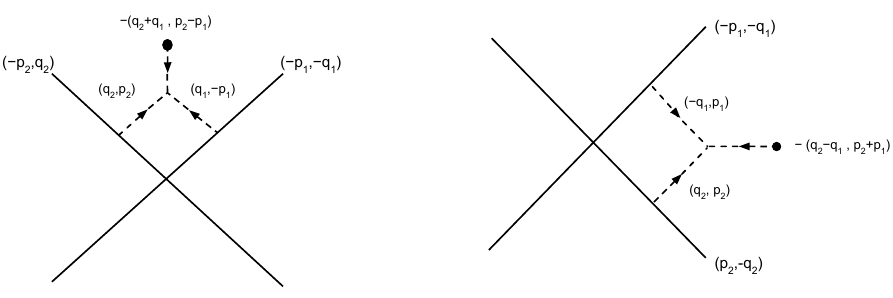
Figure 7 . Junctions formed between three open strings (dashed lines). Two of the open strings are anchored on the brane web, and the third is anchored on the probe string (black dot). Each ( p i ; q i ) brane has a (cid:6) ( (cid:0) q i ; p i )-string living on it. Two such strings can meet and form a